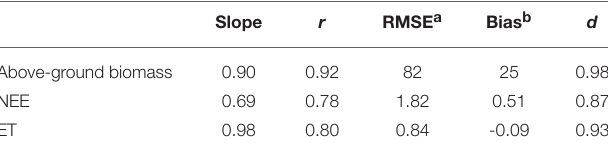
TABLE 4 | Evaluation of modeled cumulative above-ground biomass, daily net ecosystem exchange of CO 2 (NEE), and evapotranspiration (ET) for all 14 site-years.